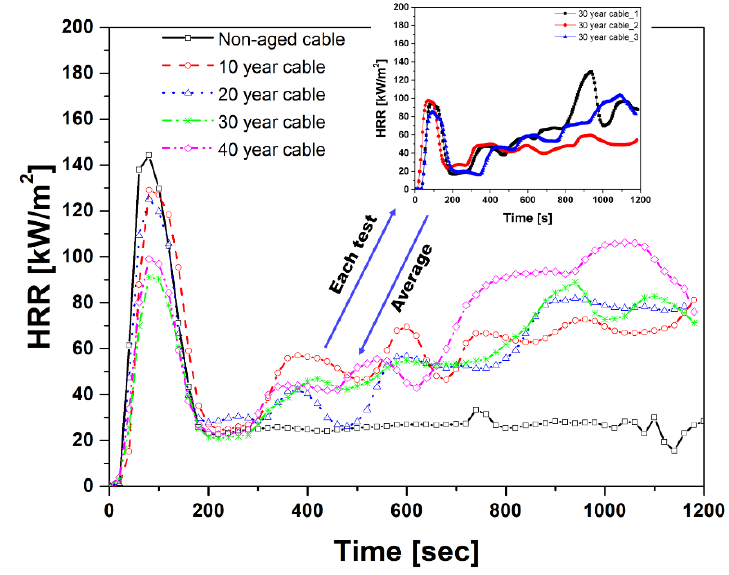
Figure 6. Time series heat release rate (HRR) with respect to the accelerated aging periods.